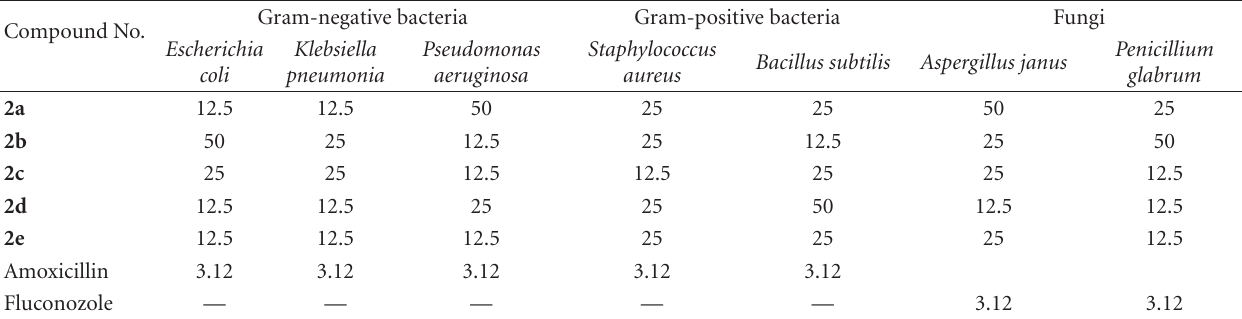
Table 2: In vitro antimicrobial MIC ( μ g/mL) of photoinduced compounds 3a-3b, 4a-4c, 5a-6a & 7 . Compound No.